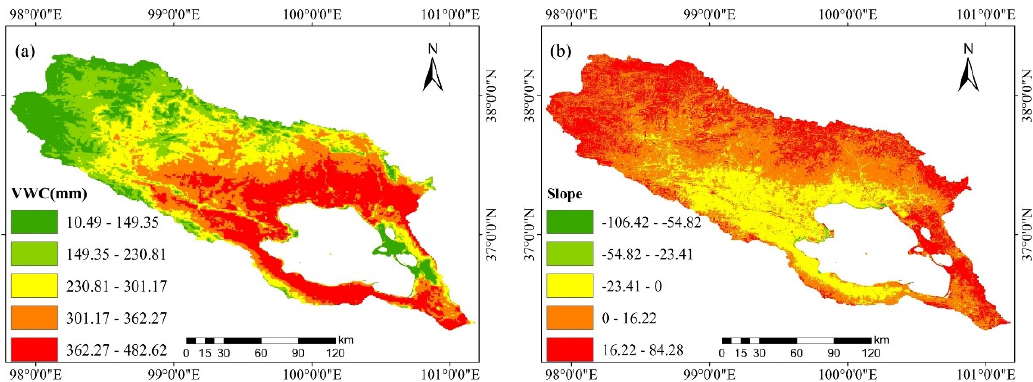
Figure 5. Spatial characteristics ( a ) and changing trends ( b ) of the VWC in the Qinghai Lake Basin from 2015 to 2020.